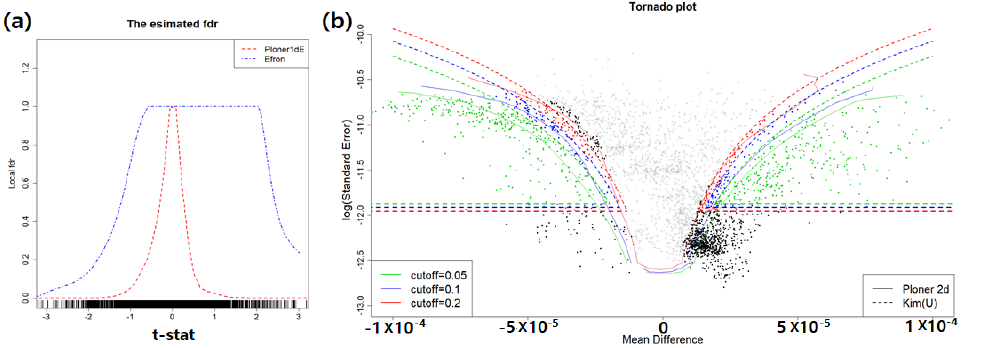
Figure 13. Omija data. ( a ): estimated fdr1d; ( b ): estimated fdr2d. The fdr2d estimates for union null are provided in the right panel of Figure 13. Each dot in the figure represents each retention time. Three different target FDRs are displayed in different colors: green (0.05), blue (0.1), and red (0.2). Surprisingly, we observe huge overlap at the top of two tornado plots. The dots rejected by Kim at the FDR level of 0.05 are presented in green. The Table 7 includes the number of rejection by each